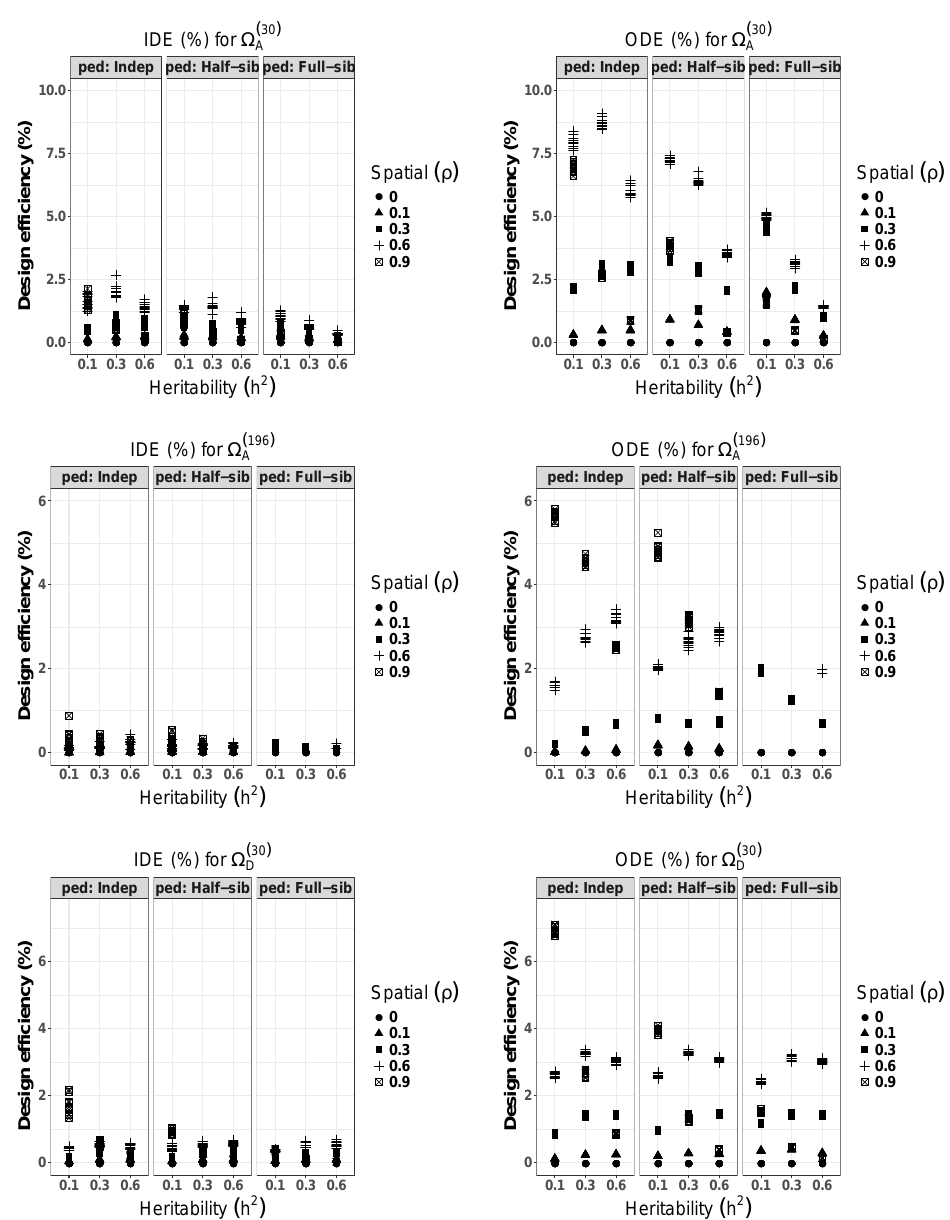
Figure 1. Initial Design Efficiency (IDE) and Overall Design Efficiency (ODE) for RCB designs with 30 genotypes generated using A -optimality criterion Ω 196 genotypes generated using A -optimality criterion Ω replicates per condition and iterated p = 5000 times to improve experimental